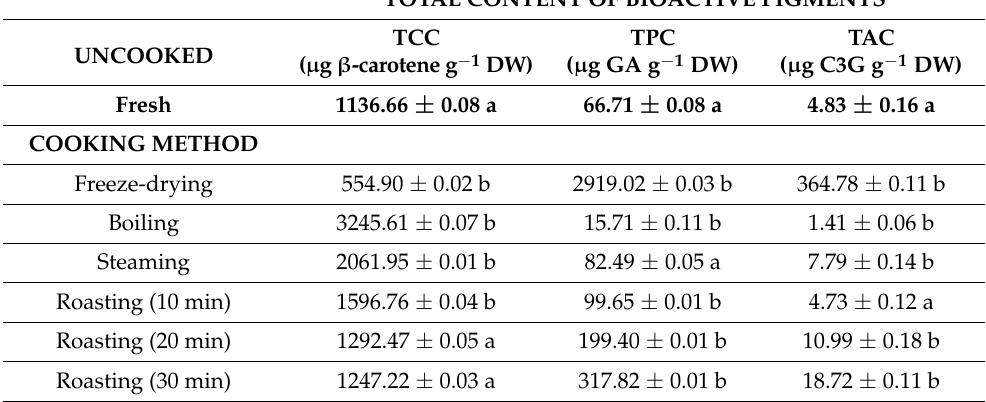
Table 2. Effect of cooking on the antioxidant pigments of purple carrots. Different lowercase letters between the sample subjected to each cooking method and fresh carrots (used as a reference) indicate differences at p <